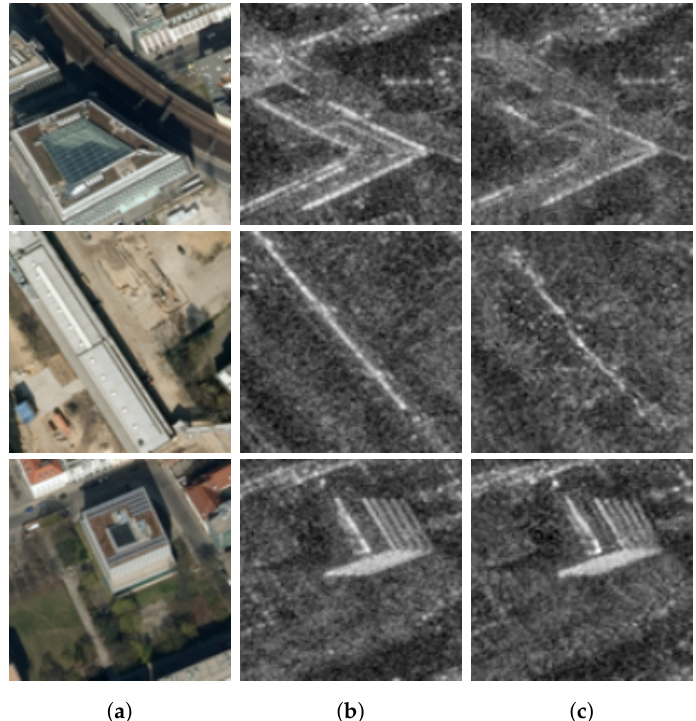
Figure 5. Using the proposed generative framework, we are able to generate SAR-like image patches ( c ) that can then be combined in conjunction with the original SAR patch ( b ), and a corresponding optical patch ( a ) in order to create a training dataset containing hard-negative